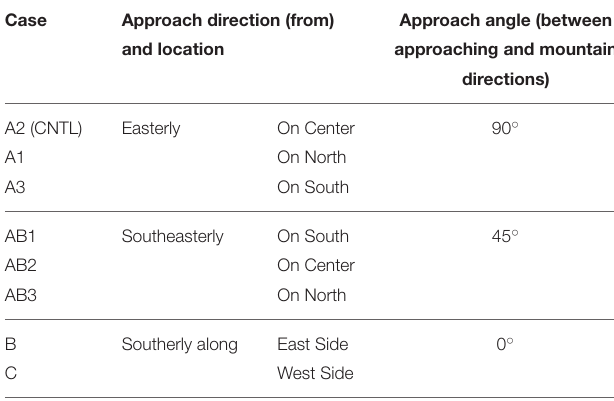
TABLE 1 | Names, landfall locations, and approach angles of simulated